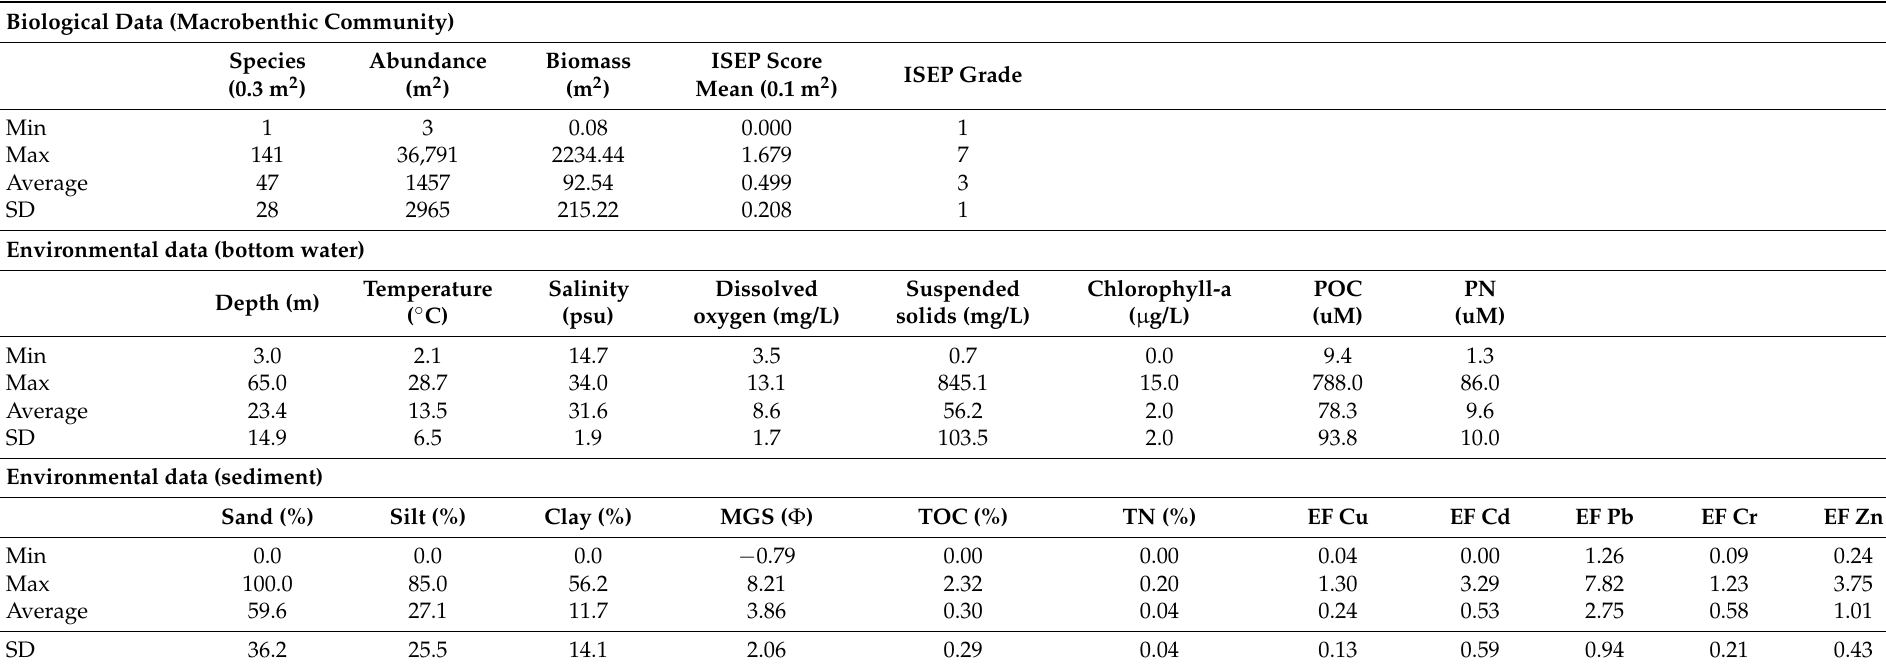
Table 3. Biological (macrofaunal community) and environmental (bottom water and sediment) data used in correlation